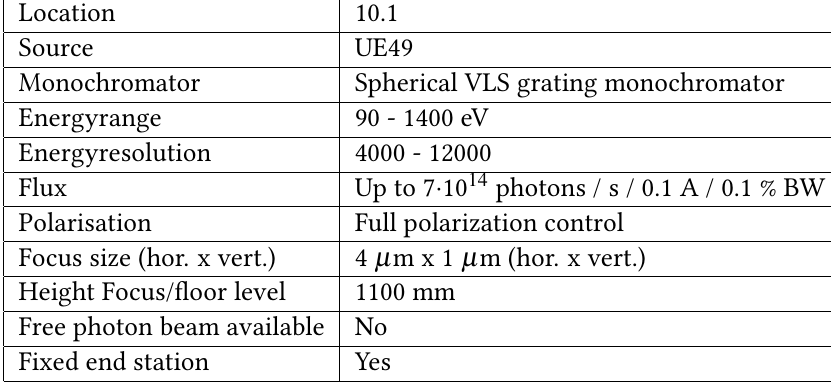
Table 2: Technical data of Beamline UE49 SGM |